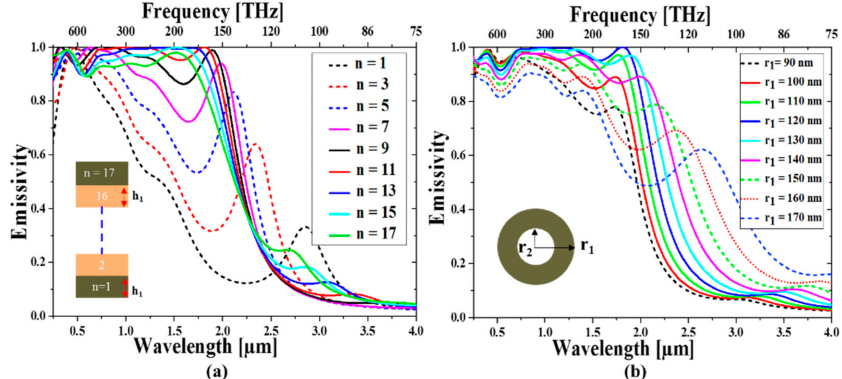
Figure 2. The emissivity spectra of the proposed metamaterial at ( a ) the variation of number of ring layers n at r 1 = 120 nm and ( b ) the change of the outer radius r 1 at n = 11. Inset in ( a ) is a side view of the number of layers and in ( b ) it is the top